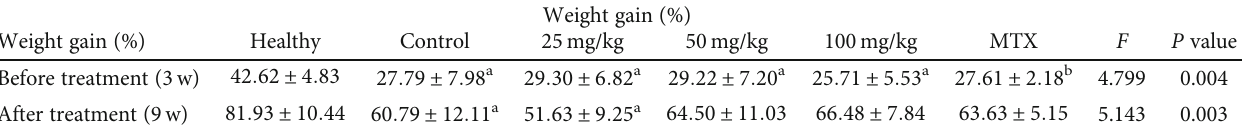
Table 1: Changes in weight gain (%) in each of the di ff erent groups before and after treatment.